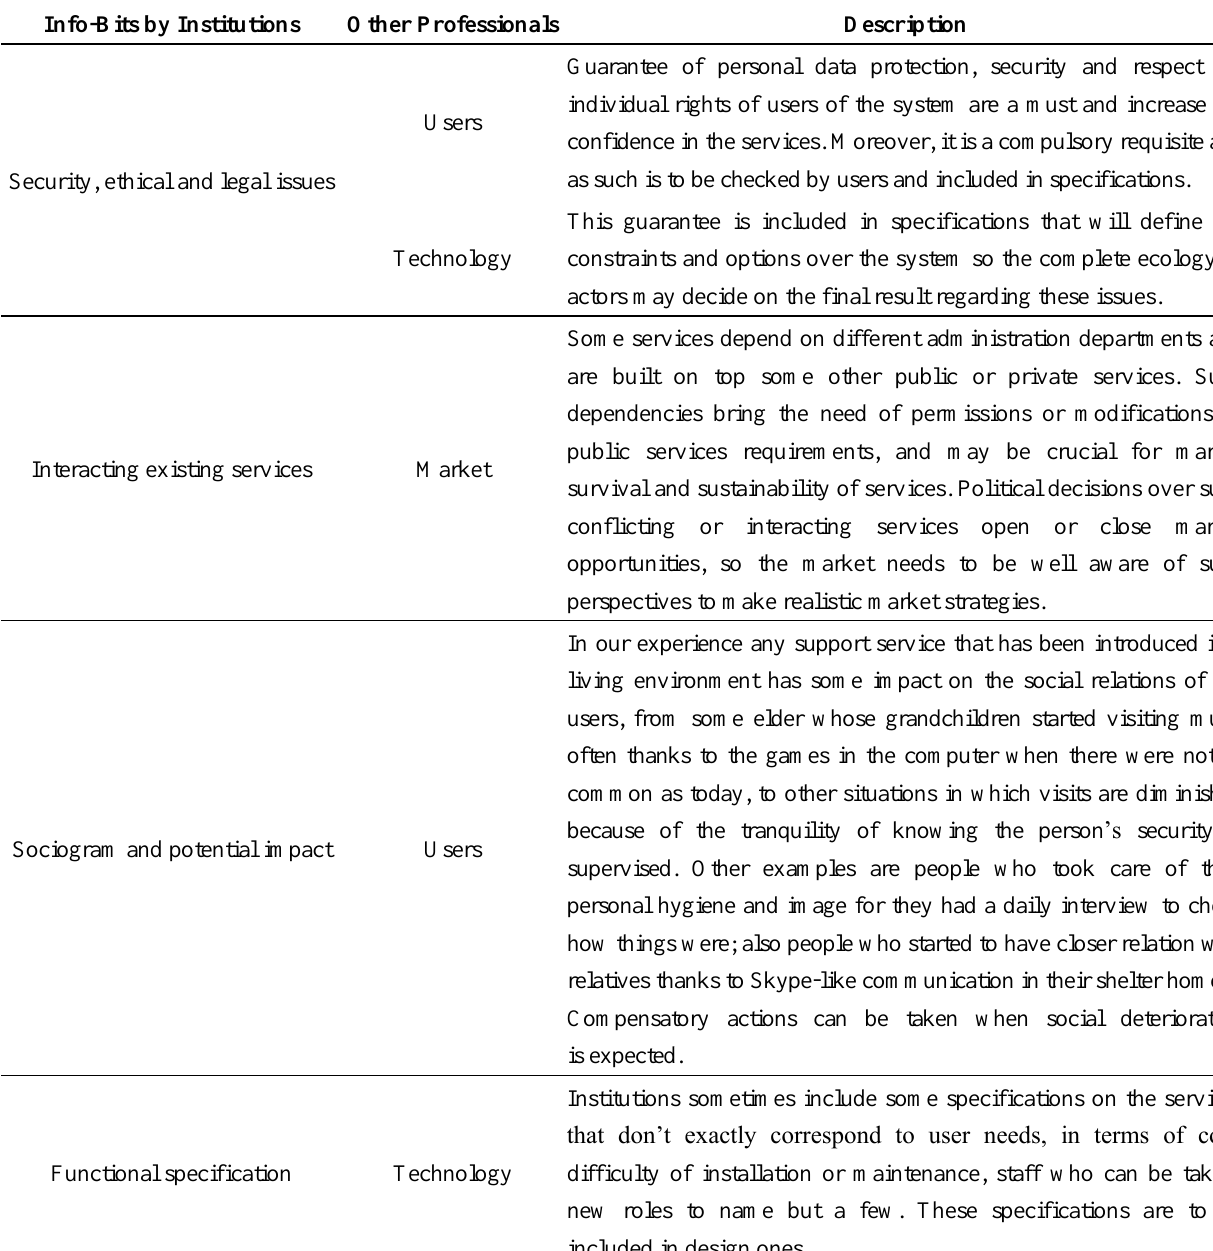
Table 4. Description of importance of information generated by institutions as received by other